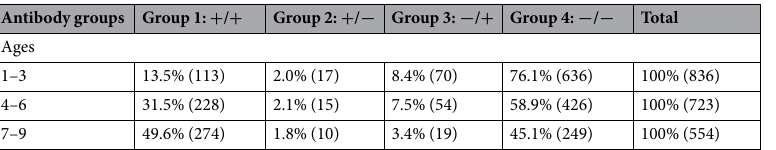
Table 4. Percentage within each age group who seroconverted, seroreverted or remained the same at one year. Group 1 vs group 2: p = 0.001. Group 1 vs group 3: p < 0.0001. Group 1 vs group 4: p <